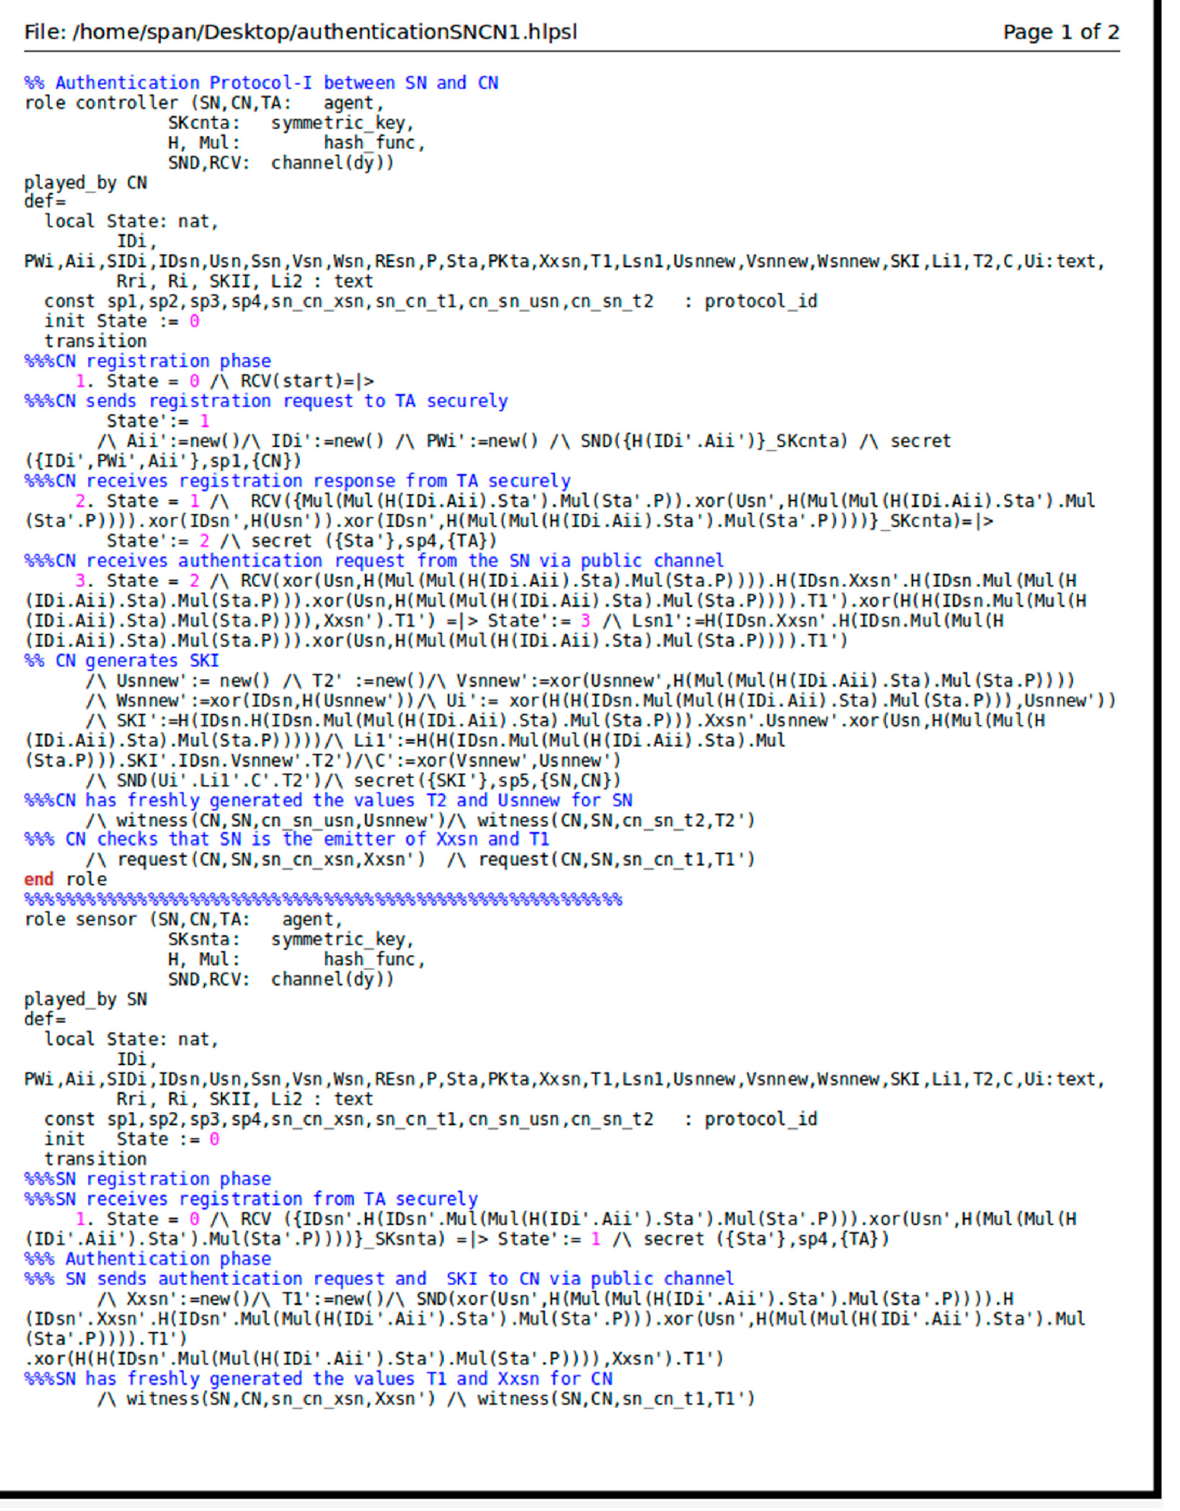
Figure 6. HLPSL code for protocol-I.